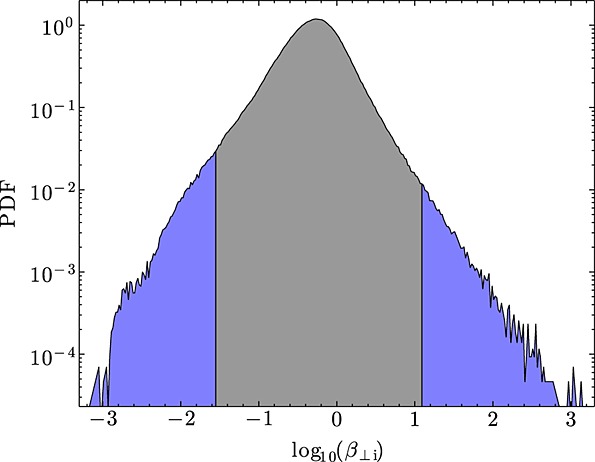
Probability density function (PDF) of log10(β⊥i) in the solar wind. Intervals used in this letter are from the extreme parts of the distribution with β⊥i≪1 and β⊥i≫1 shaded in blue.